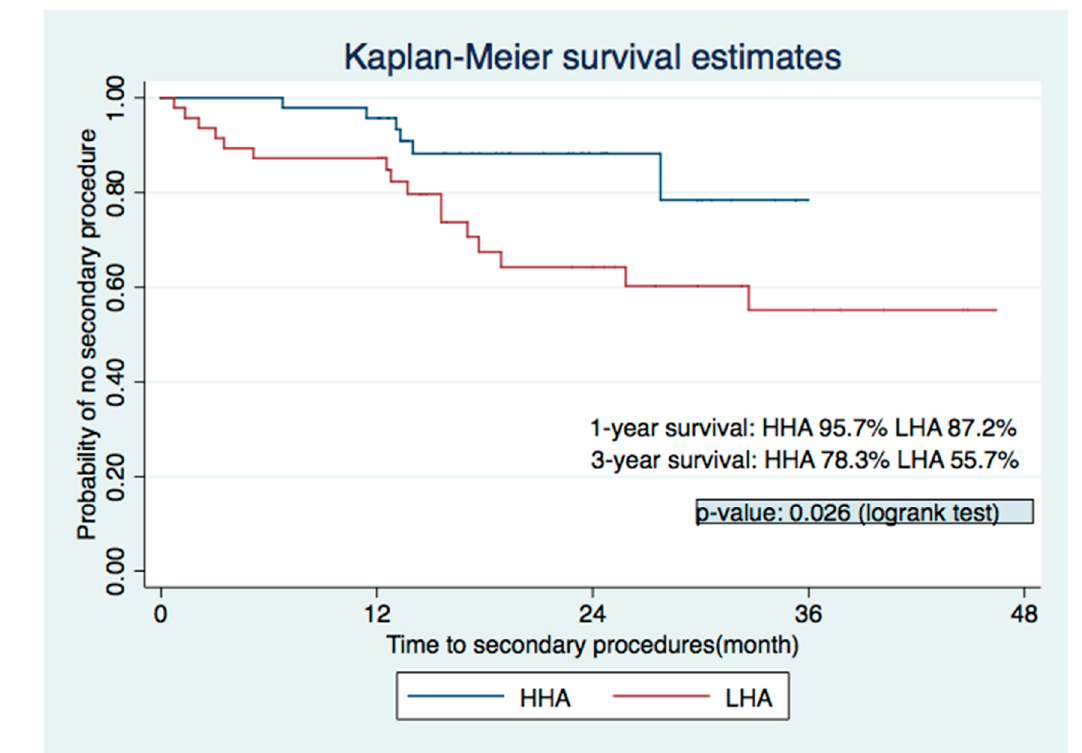
Figure 3. Kaplan–Meier estimates showed significantly better prognosis in the HHA group. HHA = high-concentration HA group; LHA = low-concentration HA group. group; LHA = low-concentration HA